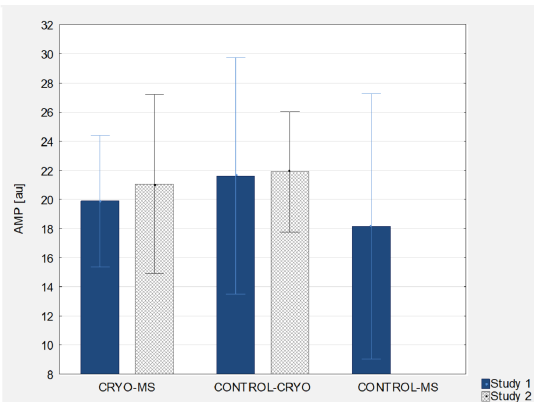
Figure 3. Morphological and rheological indices of blood in experimental group and control groups (study 1 and study 2, respectively).